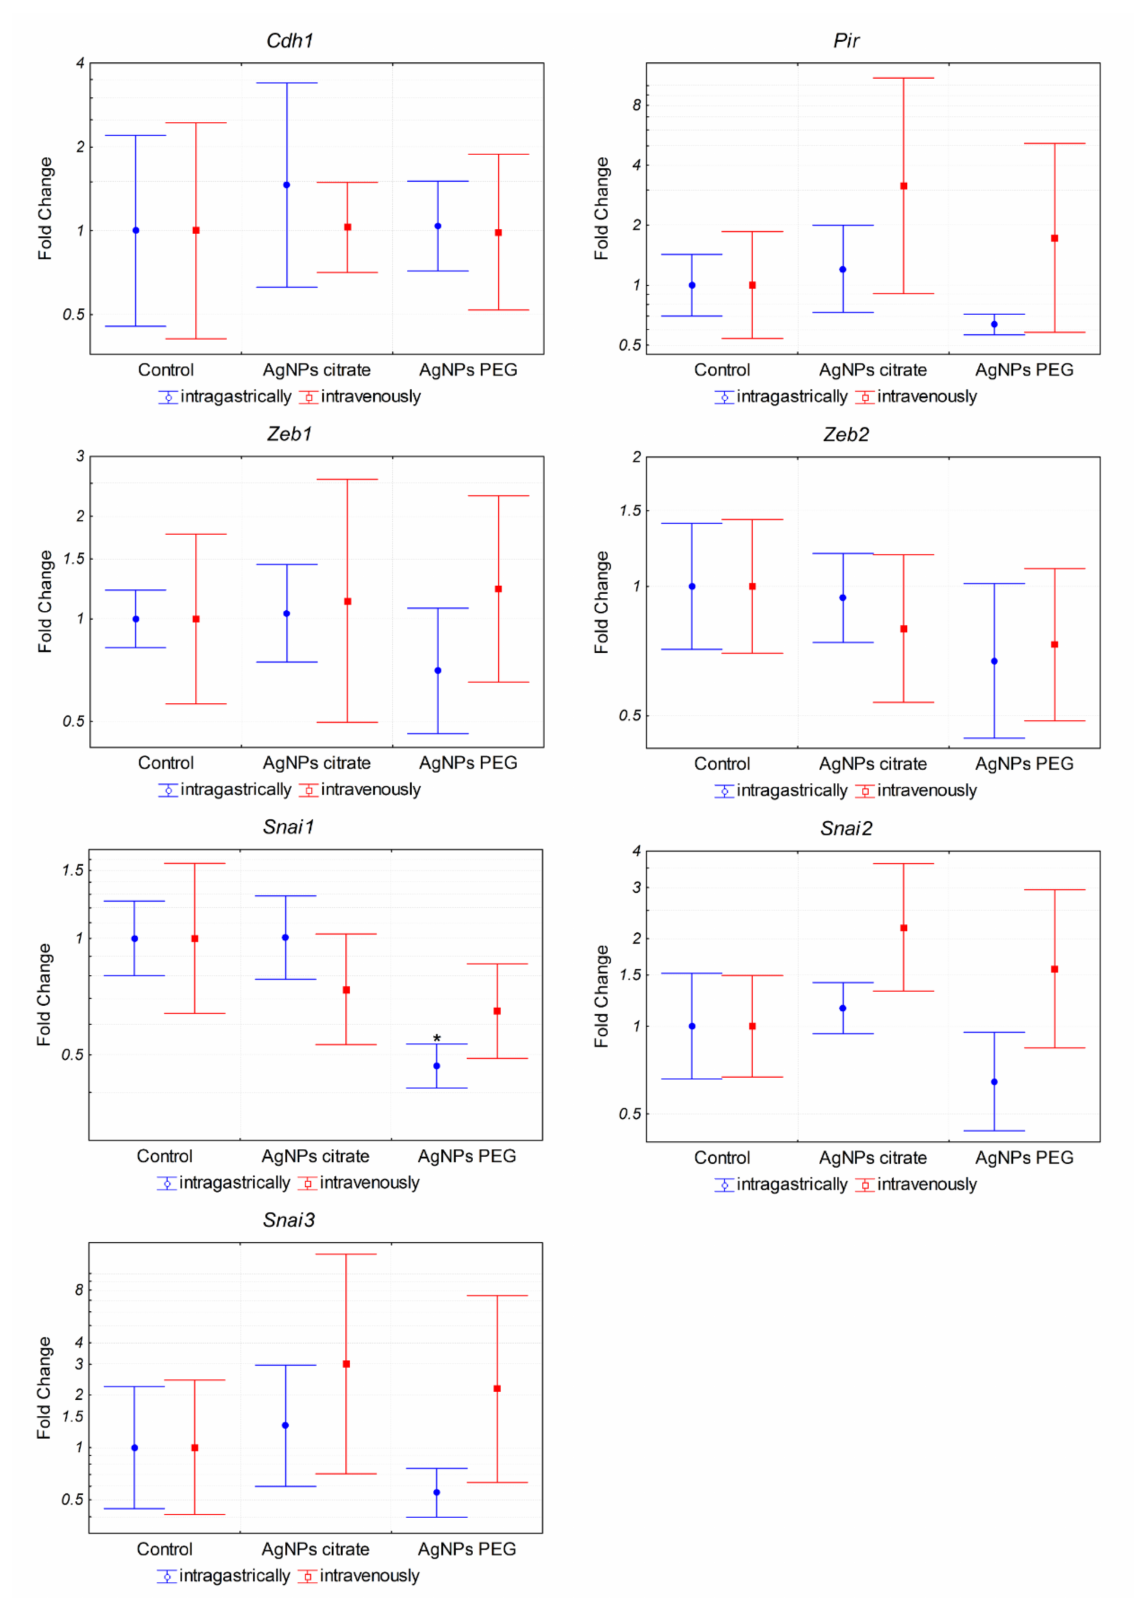
Figure 4. Expression of EMT-related genes at the mRNA level in tumors from mice treated intragas- trically or intravenously with 1 mg/kg citrate- or PEG-coated AgNPs. Markers represent mean fold change values and whiskers represent the minimum and maximum fold change calculated from a standard deviation of ∆ Ct values. * p < 0.05 difference versus control group, n =